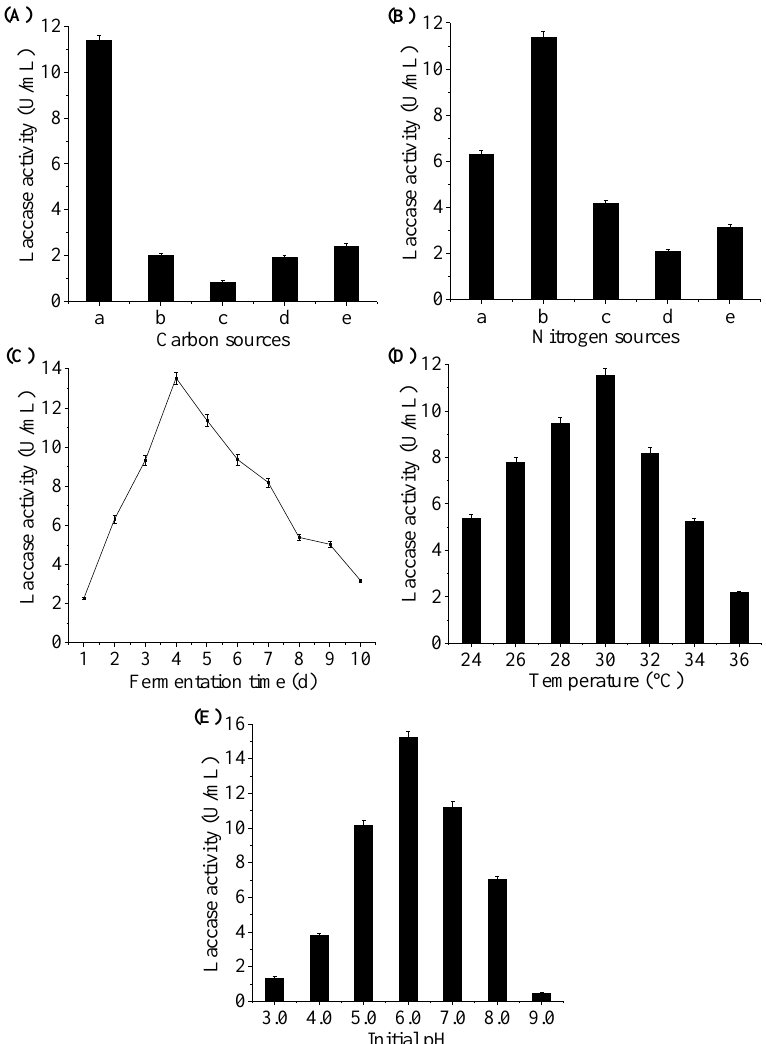
Figure 2. Effects of nutrient and fermentation factors on laccase production by M. verrucaria MD-R-16. ( A ) Effect of carbon sources on laccase production. The carbon source (from a–e)